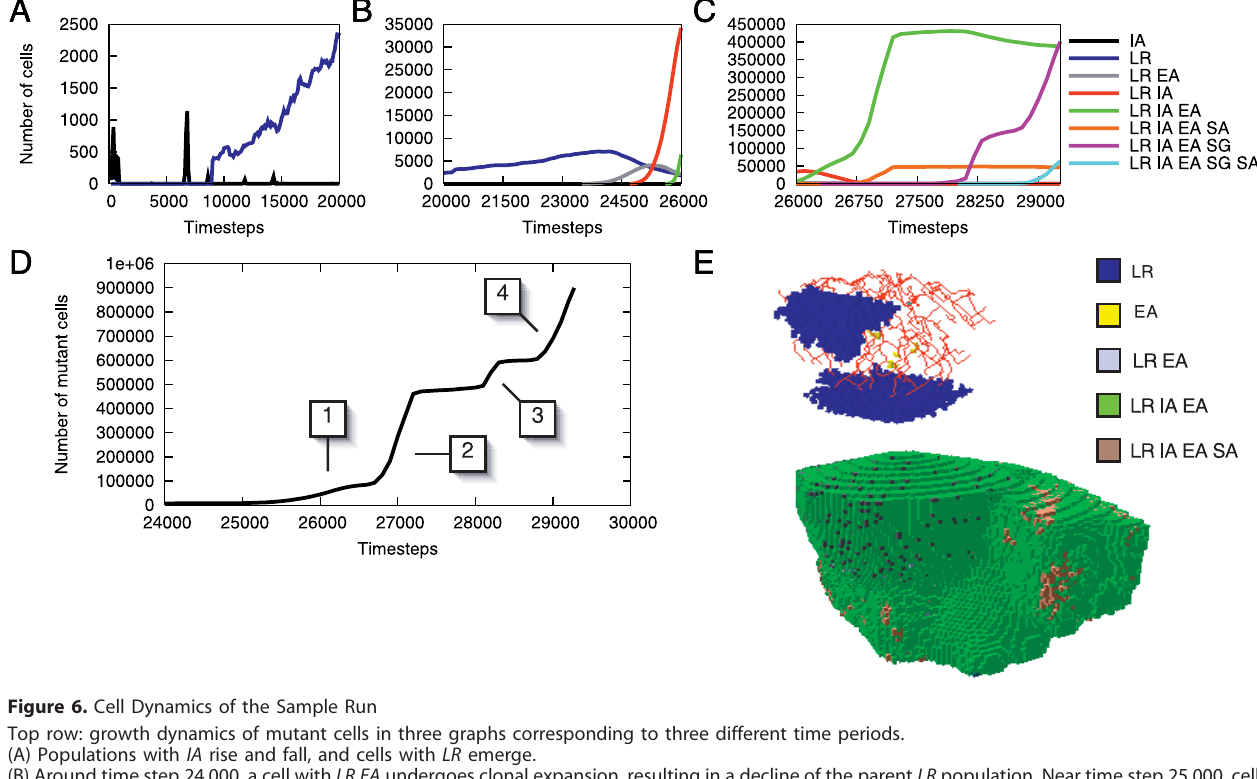
Figure 6. Cell Dynamics of the Sample Run Top row: growth dynamics of mutant cells in three graphs corresponding to three different time periods. (A) Populations with IA rise and fall, and cells with LR emerge. (B) Around time step 24,000, a cell with LR EA undergoes clonal expansion, resulting in a decline of the parent LR population. Near time step 25,000, cells with LR IA begin to outcompete the LR EA population. (C) At time step 26,000, cells with LR IA EA expand while the LR IA population declines. The emergence of a clonal population with LR IA EA SA provides the angiogenesis for the LR IA EA population to expand rapidly. At time step 28,000, LR IA EA SG cells begin to double the size of the tumor, aided by the LR IA EA SG SA cells. (D) The aggregate cell proliferation pattern in mutant cells. The boxed numbers indicate clonal expansions that result from overcoming proliferation bottlenecks. The first expansion occurs with the acquisition of IA. The second expansion is the result of an SA mutation. The third occurs with the acquisition of SG, and the final expansion occurs with the acquisition of SA. (E) The tissue at time step 20,780 (top) and 26,982 (bottom). Normal cells have been removed from the image to reveal two clonal populations with LR at time step 20,780. At time step 26,982, the tumor has grown beyond the normal tissue extent through the acquisition of SA. DOI: